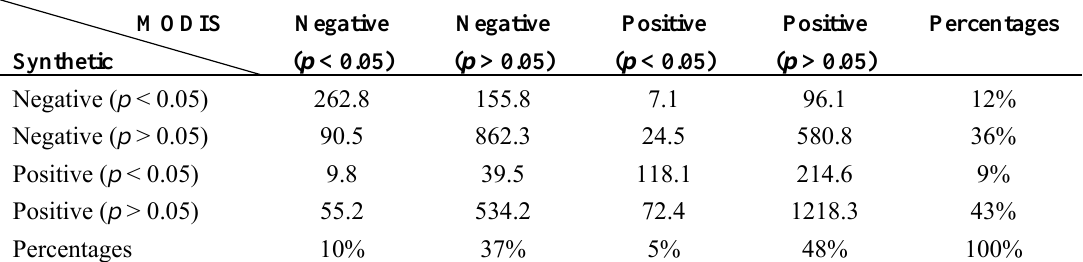
Table 4. Cross-tabulation considering the significance of NDVI synthetic and MODIS time series (2000–2011). The chi-square test of the cross-tabulation showed a significant ( p < 0.001) relationship between the two trend maps with a contingency coefficient of 0.57 out of 0.86 (values in km 2